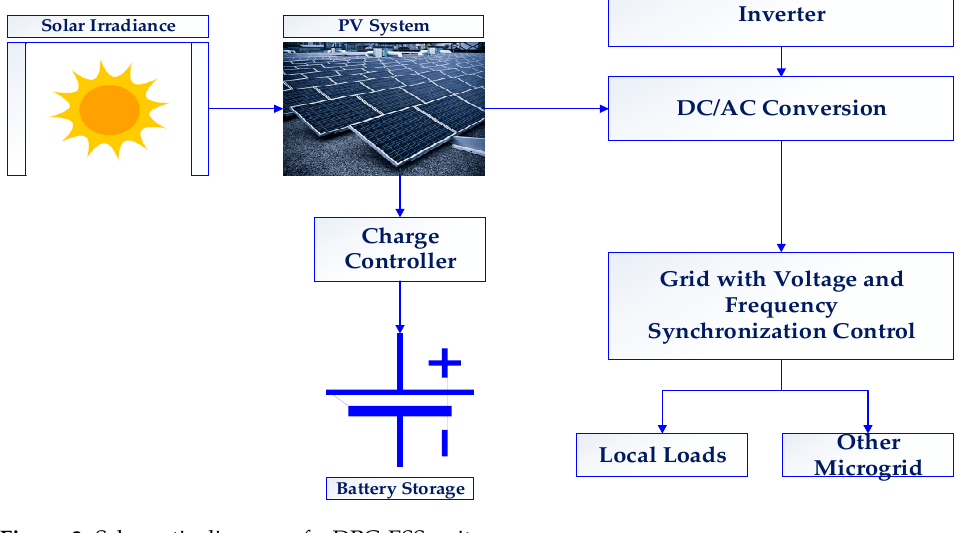
Figure 3. Schematic diagram of a DPG-ESS unit.